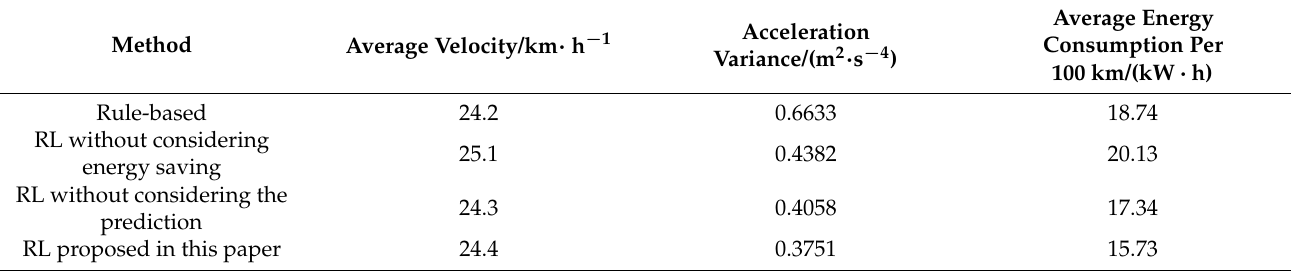
Table 5. Comparison of trajectory characteristics of different